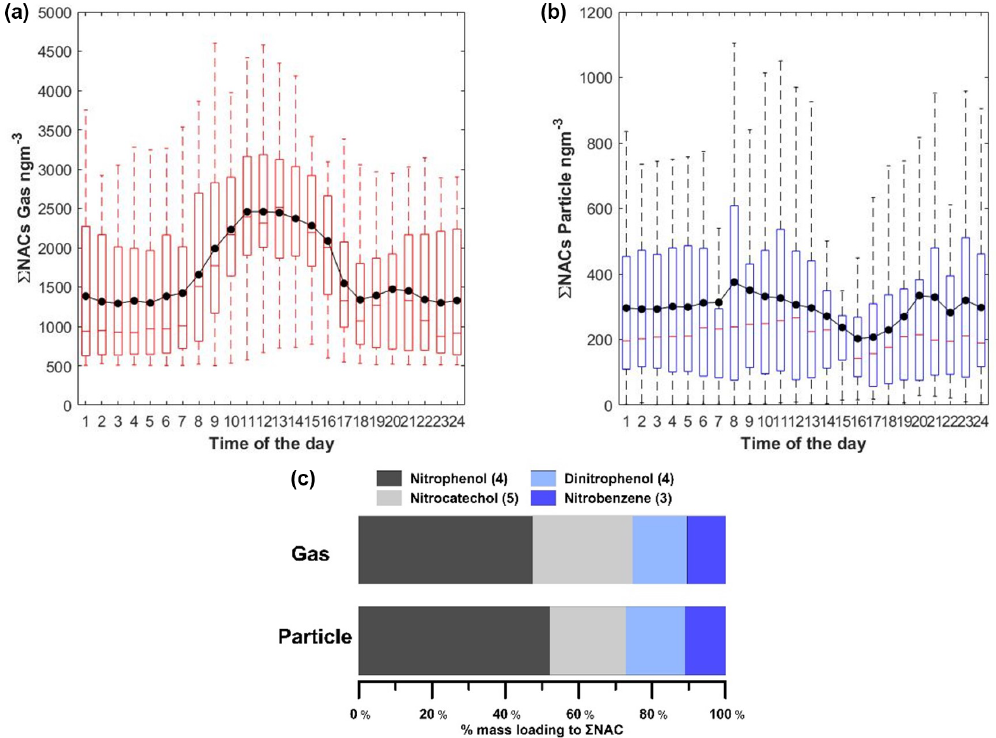
Figure 3. (a, b) Diurnal profile of the sum of NACs in the gas (a) and particle (b) phases. The solid black line indicates the hourly average. Note that outliers are not shown in the figure. (c) Molecular distribution of NACs in the gas and particle phases, classified according to similarity to major NACs. Values in parentheses indicate the number of compounds per